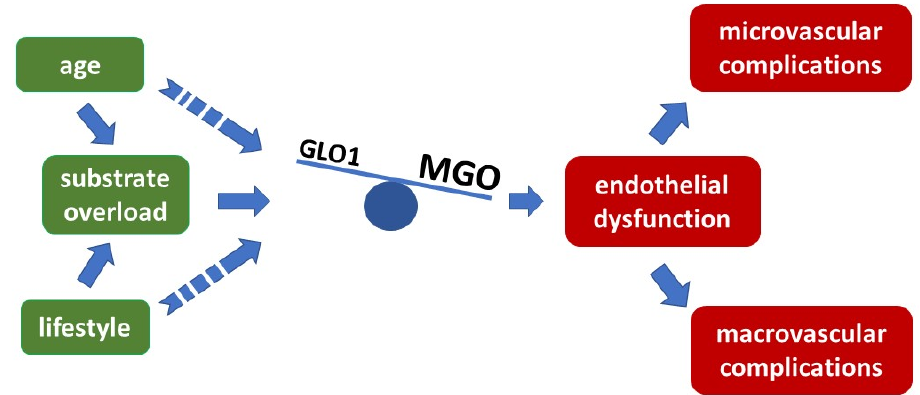
Figure 2. Imbalance of glyoxalase 1 activity and MGO concentration provoke endothelial dysfunction preceding atherosclerotic events, overflow with MGO exceeds the detoxifying capacity of GLO1 and results in endothelial dysfunction and further late complications.